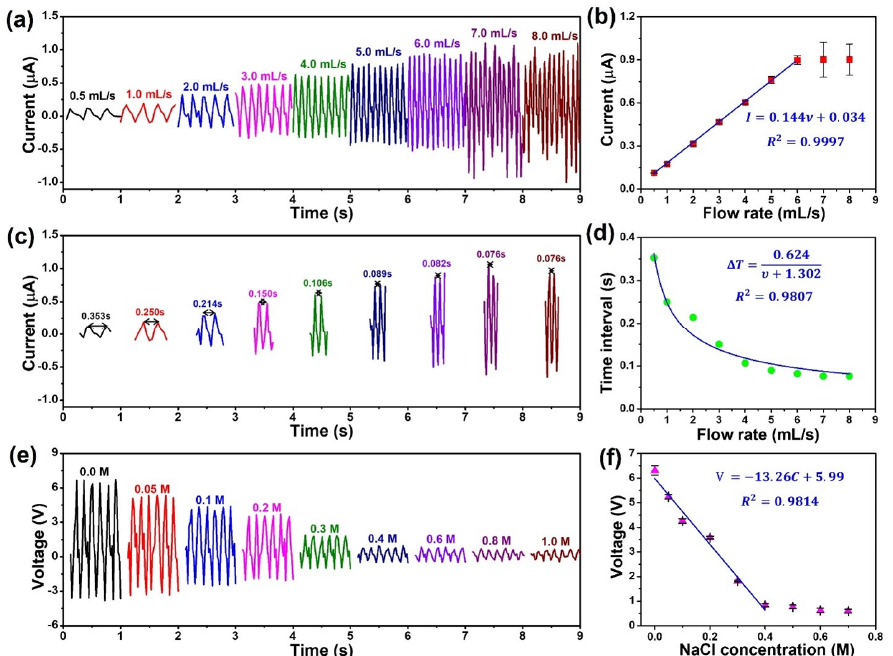
6666666 Figure 6. ( a ) Output current of PSPE-TENG depending on the water flow rate, ( b ) regression analysis of flow rate based on output current; ( c ) calculate the time interval between two peaks of current working on different water flow rates, ( d ) regression analysis of flow rate based on time interval; ( e ) output voltage of PSPE-TENG depending on NaCl concentration, ( f ) regression analysis of NaCl concentration based on output